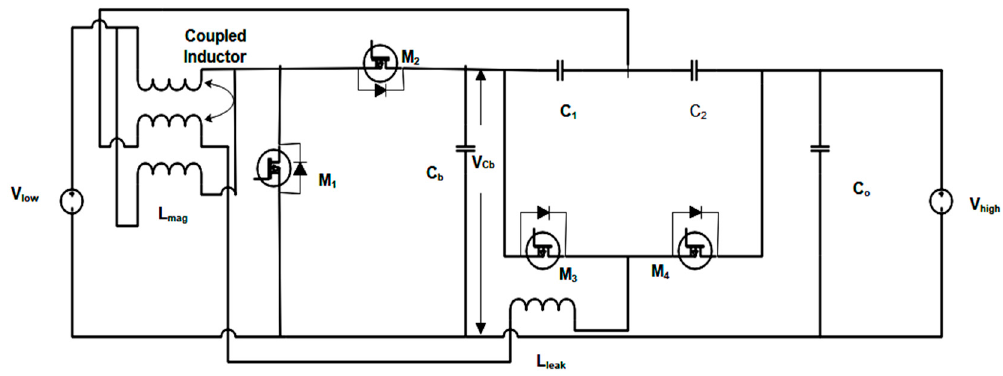
Figure 2. Circuit diagram for bidirectional DC–DC converter.